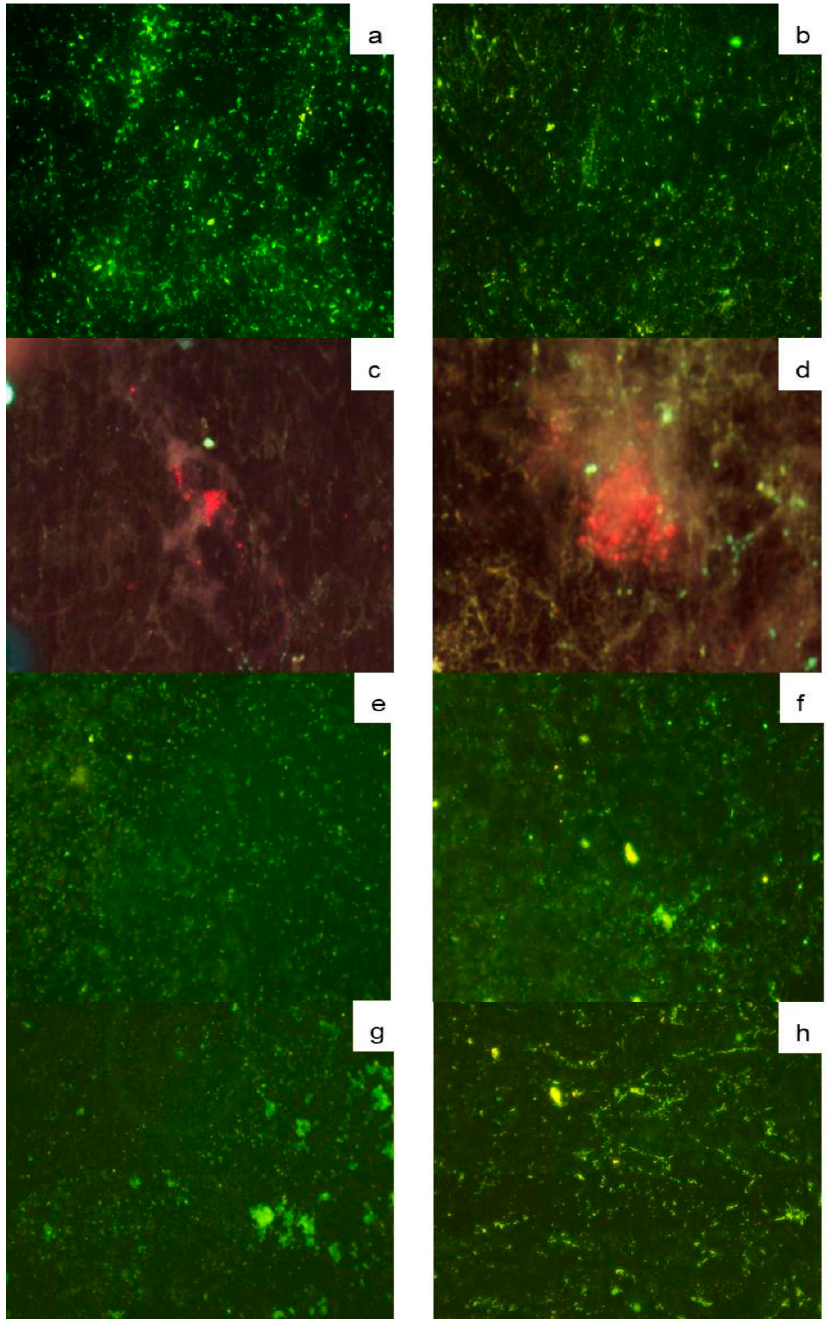
Figure 6. FISH micrographs (40X) of SSP plates with biofilms on type A (panels a , d , e , g ) and B deposits (panels b , d , f , h ), hybridized with the probes EUB338 ( a , b ); PF2 ( c , d ); Strc493 ( e , f ) and Lis-637 ( g , h